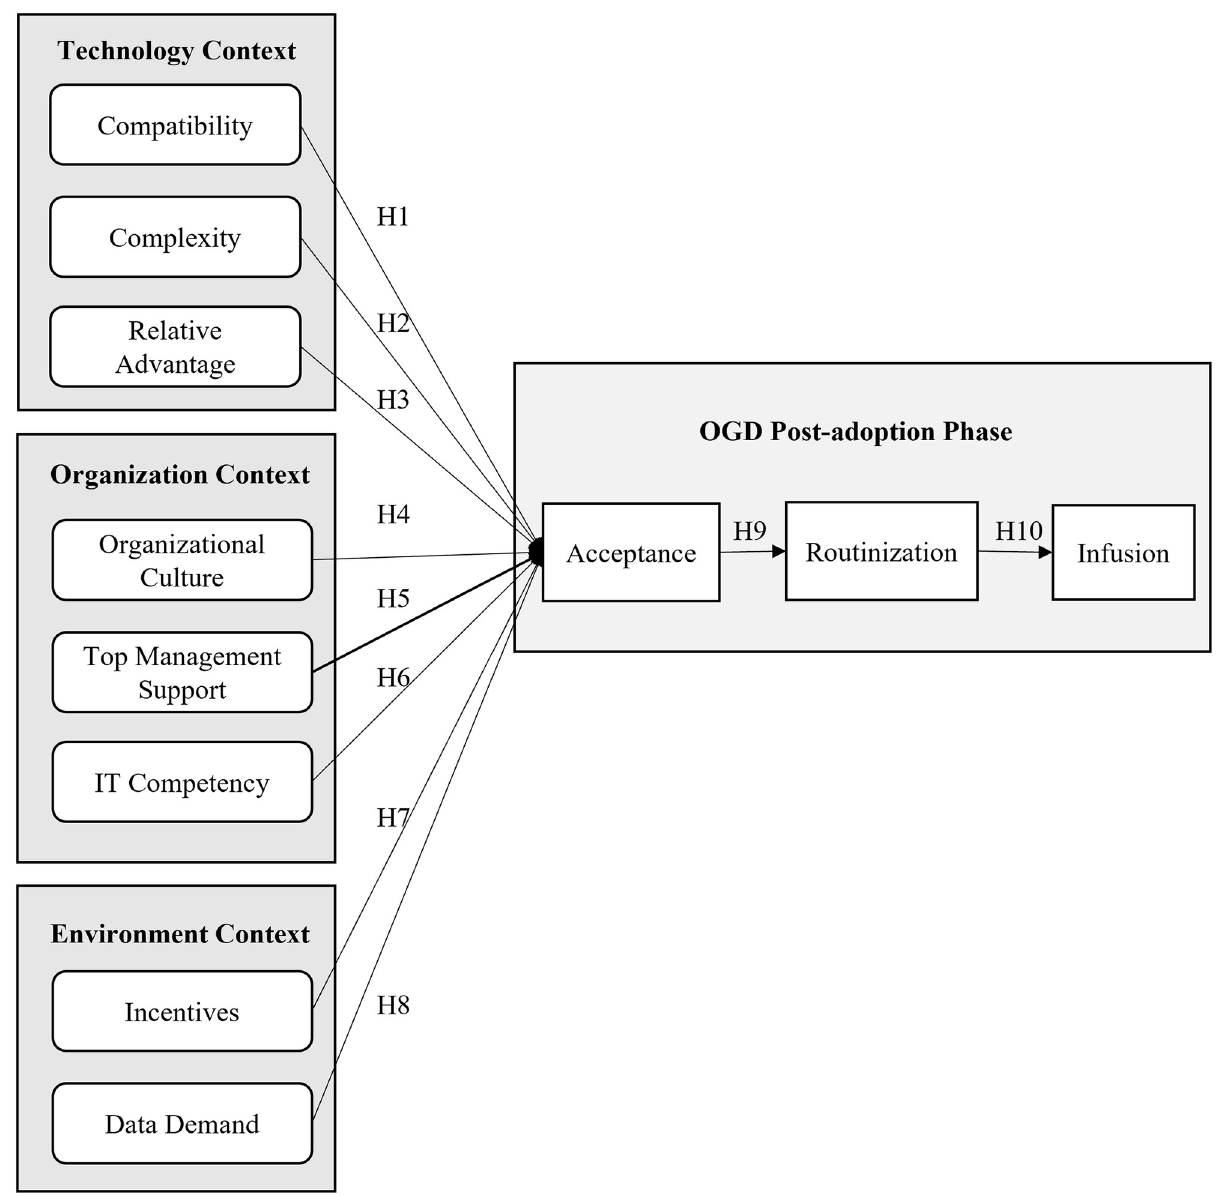
Fig 1. The research model for the OGD post-adoption framework in the public